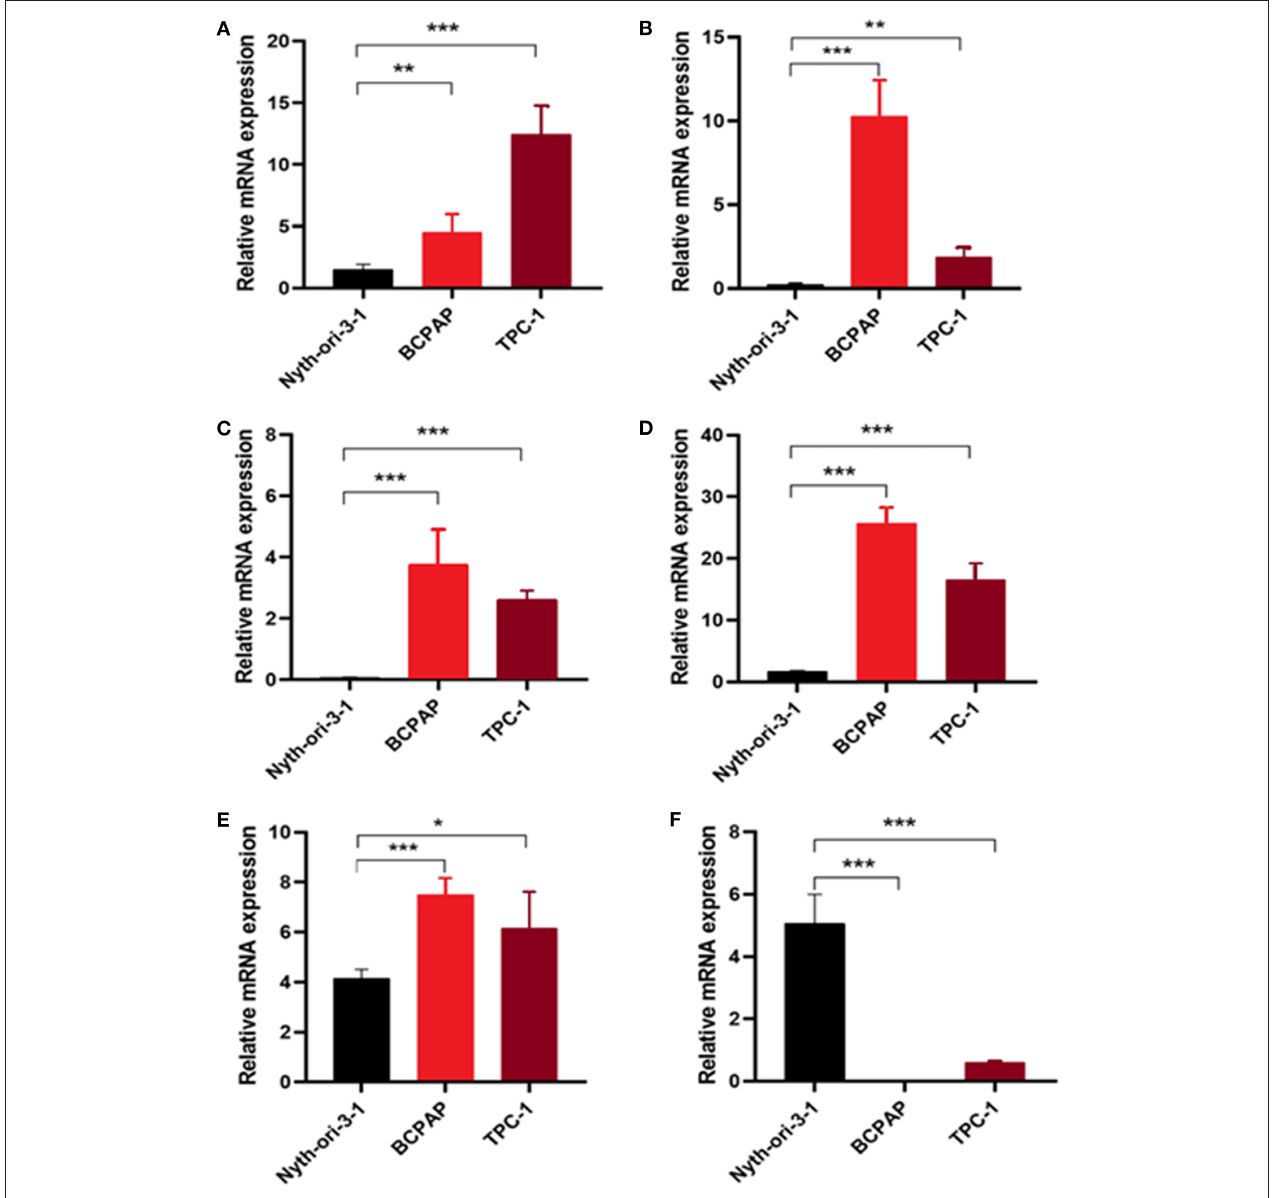
FIGURE 6 | Measurement of glycolysis-related genes at mRNA levels in cell lines. Relative mRNA levels of (A) CHST6, (B) FBP2, (C) PPFIA4, (D) POM121C, (E) TGFBI, and (F) STC1 in thyroid cancer cells (BCPAP and TPC-1) and thyroid cells (Nyth-ori-3-1). * p < 0.05, ** p < 0.01, and *** p < 0.001.